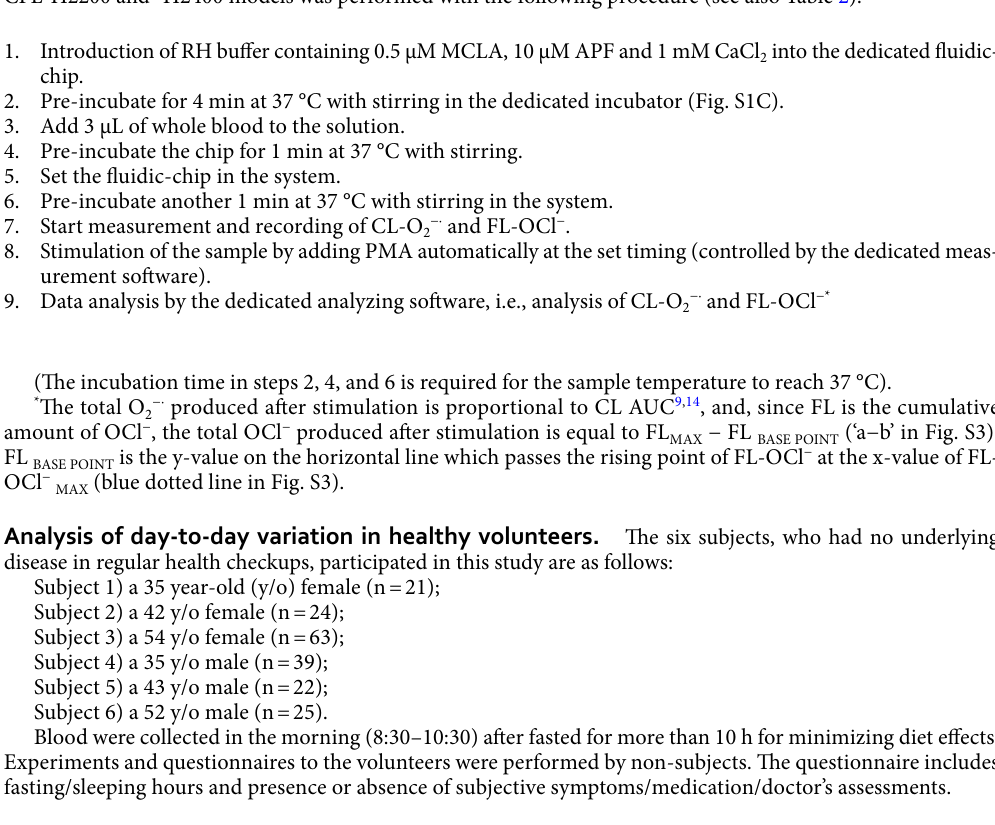
Whole blood collection. Blood samples were self-collected from fingertips of volunteers by using a lancet (Becton, Dickinson and Company, Franklin Lakes, NJ, USA or Nipro, Osaka, Japan). They were preserved in BD Microtainer Tubes (Becton, Dickinson and Company, Franklin Lakes, NJ, USA) whose inside was coated with